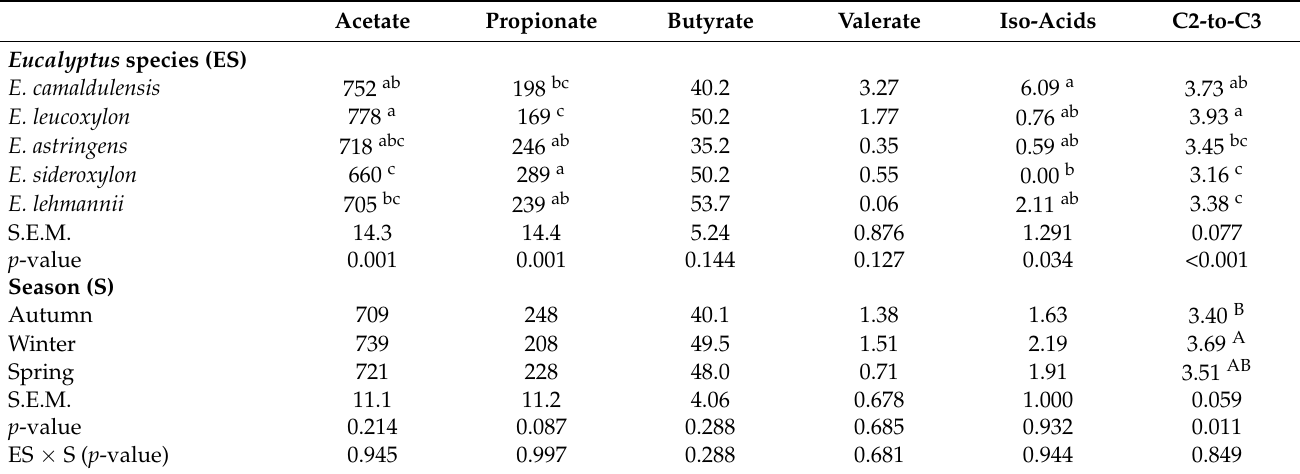
Table 4. Molar proportions of volatile fatty acids (mmol per mol of total VFA) when the foliage of eucalyptus species harvested in different seasons was incubated in vitro in buffered rumen fluid for 24 h. Acetate Propionate Butyrate Valerate Iso-Acids